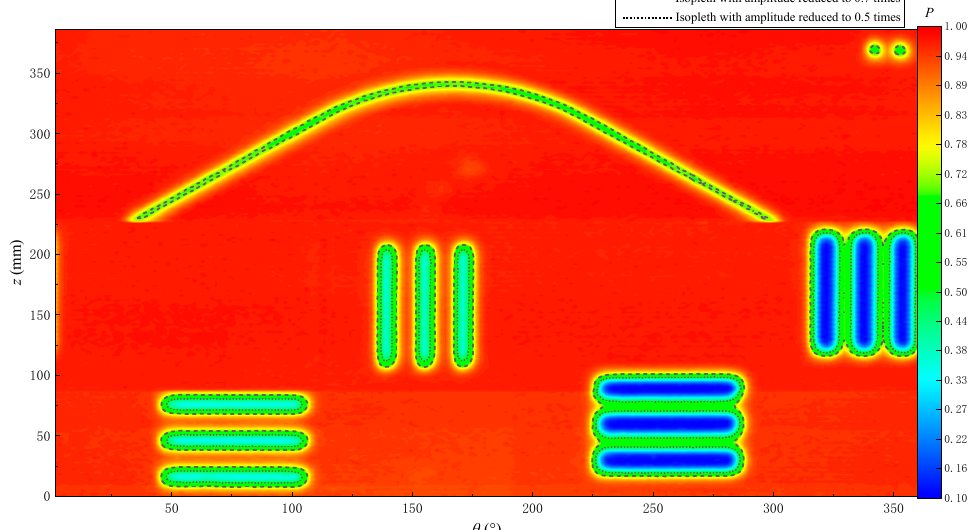
Figure 25. Echo amplitude imaging for the simulated borehole. The dip angle of the oblique fracture in the simulated borehole is calculated, and the side expanded view and its projection on the horizontal plane is shown in Figure 26. R is the borehole radius, point A is the highest point of the fracture, point B is the midpoint of the line connecting between the two lowest points of the fracture and h is the distance between points AB in the side expanded view. l is the distance between points AB, β is the center angle of the arc formed between point A and the lowest point in the projection on the horizontal plane. The formula to calculate the oblique fracture dip angle α is as follows [20]: ( b ) Figure 26. Schematic for the calculation of dip angle of oblique fracture. ( a ) Side expanded view of oblique fracture. ( b ) Projection of oblique fracture on the horizontal plane.